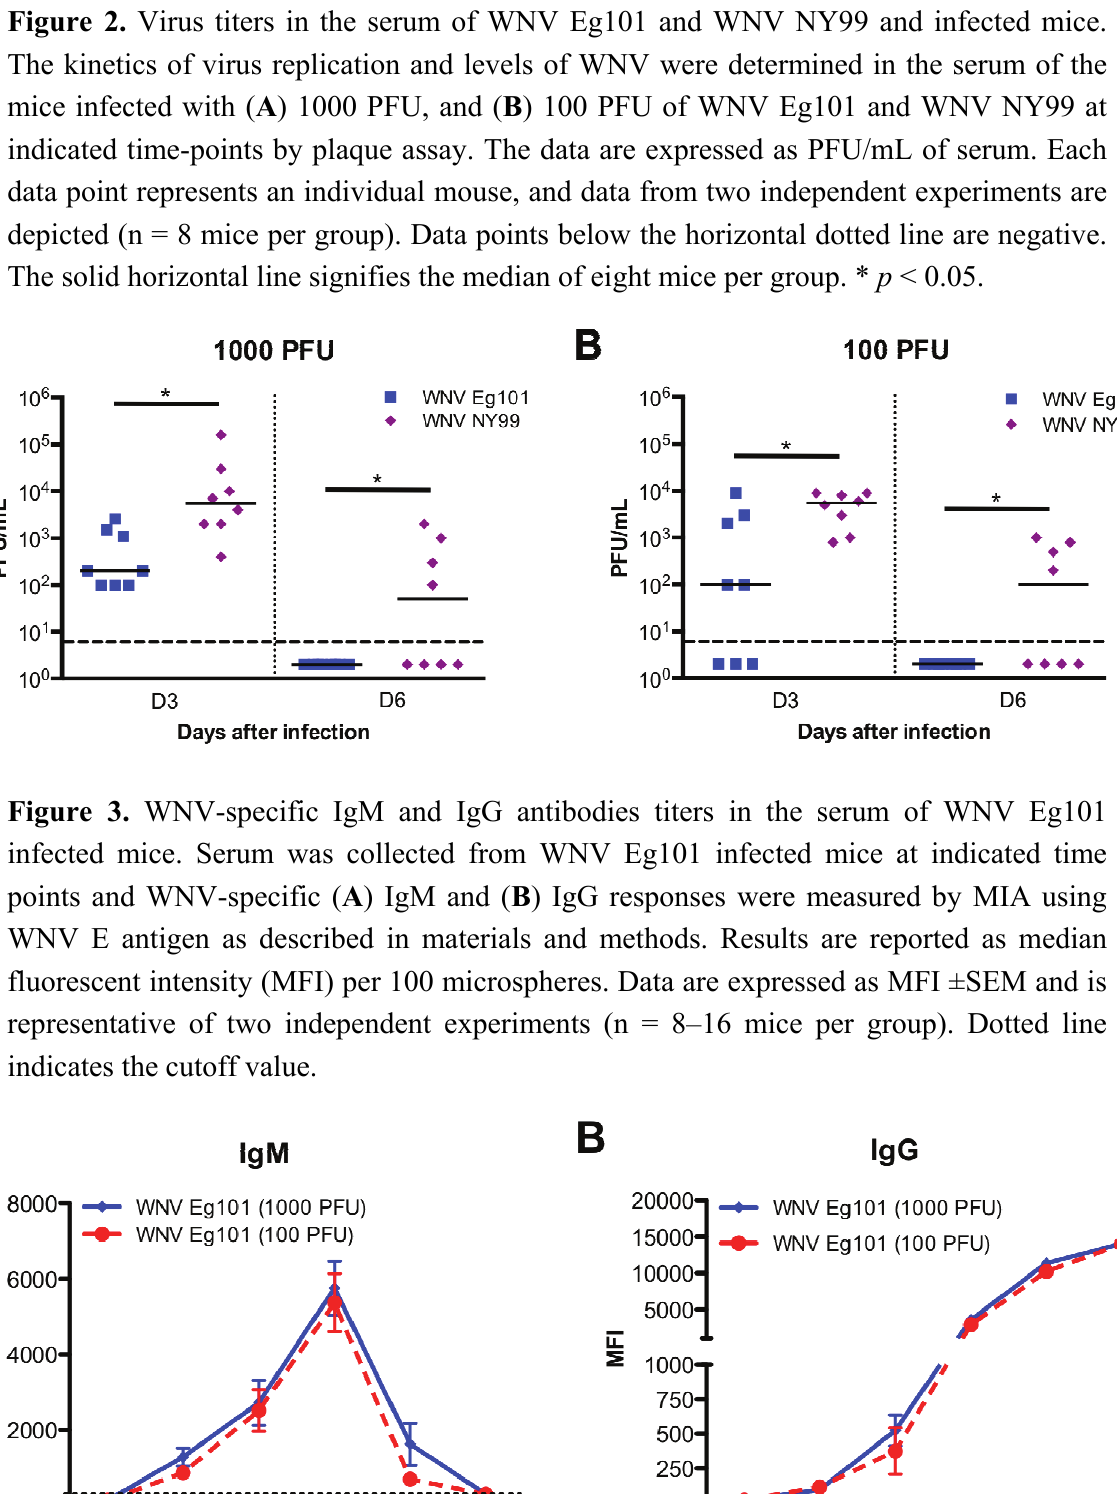
3.4. WNV Eg101 Infection Induces Cross-Reactive Antibodies that Neutralize the WNV NY99 Strain Serum from WNV Eg101 infected mice was tested for neutralizing antibodies against WNV Eg101 and WNV NY99 strains using PRNT assay. High titers of neutralizing antibodies to WNV Eg101